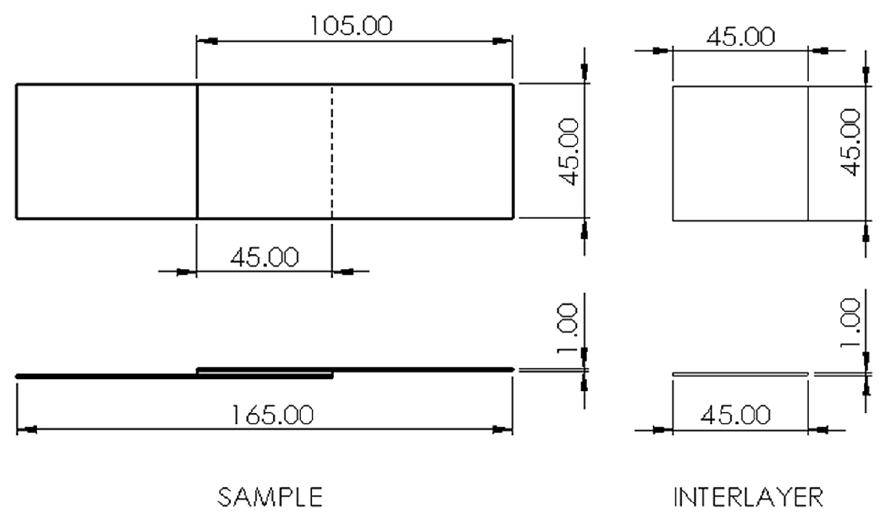
Fig. 3 Dimension of sheets and interlayer (in mm)